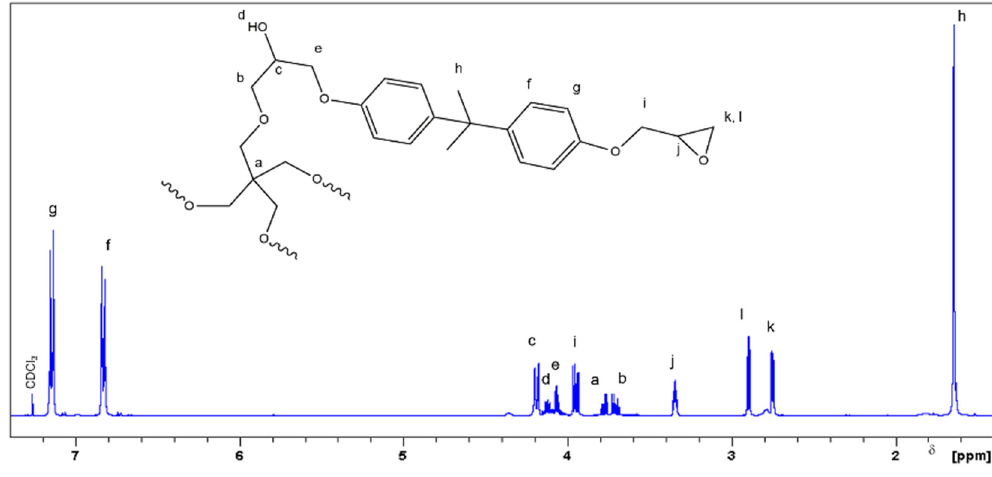
Figure 2. 1 H NMR spectrum of HBE resin.